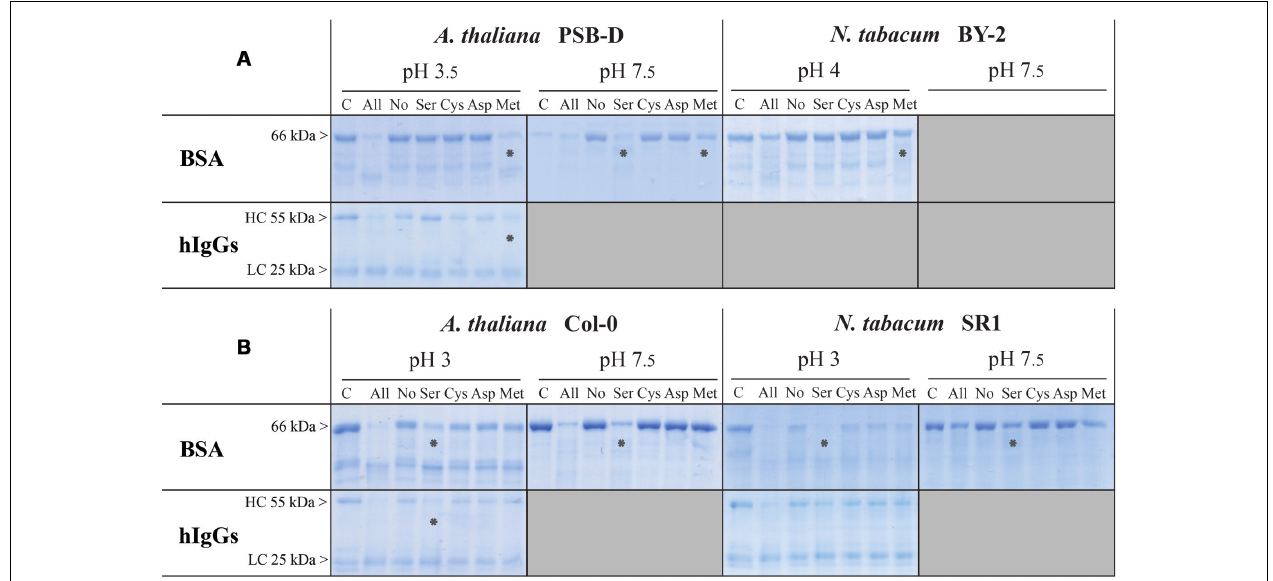
FIGURE 3 | Identification of peptidase classes responsible for target degradation in A. thaliana and N. tabacum EM or RZ. Samples were collected from (A) 7-days-old suspension cells (EM) or (B) 7-weeks-old hydroponic cultures (RZ). Before a six- (EM) or a 3-h incubation (RZ) at 25 ◦ C with the target proteins (BSA or hIgGs), samples were pre-incubated for 30 min at 25 ◦ C without peptidase inhibitors (all proteases are active; ‘All’), or with a mix of four peptidase inhibitors (PMSF, E64, pepstatin A, and EDTA; none is active; ‘No’), or with a mix of three of these inhibitors. Omitting one of the inhibitors left only one peptidase class active: omitting PMSF, E64,